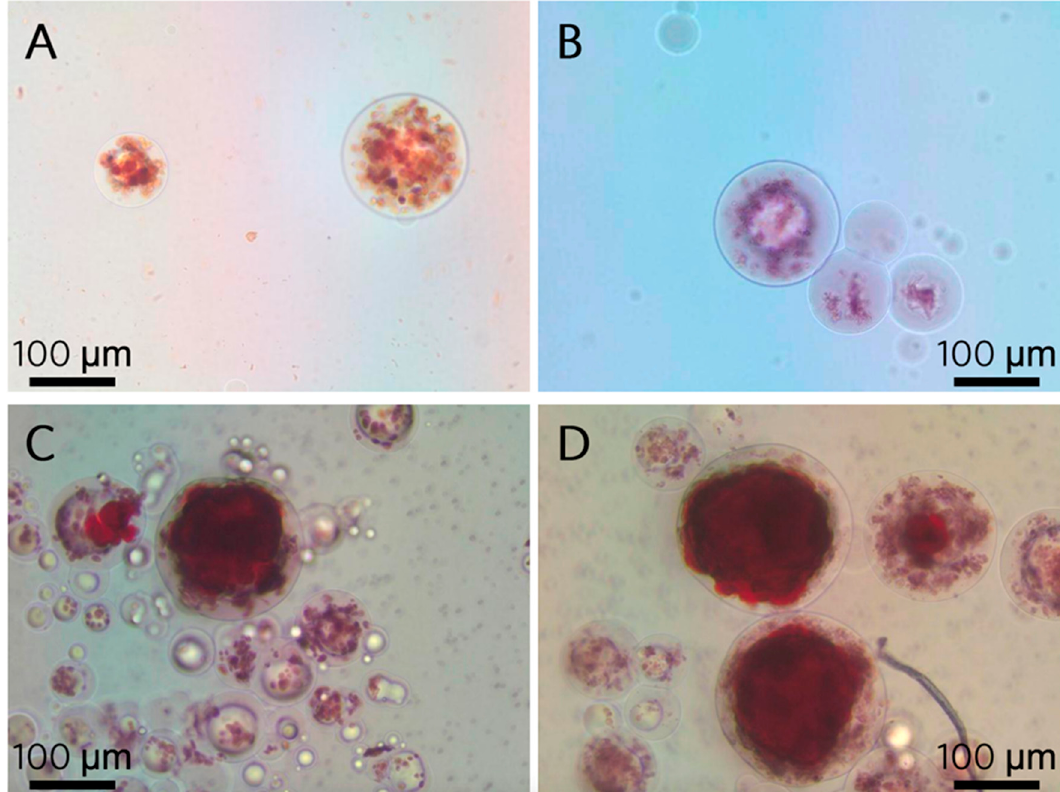
Figure 4. Representative Alizarin Red S stain of hydroxyapatite deposits at 2, 7, 32, and 50 days ( A – D ). ( A – C ) Complete maintenance basal media, ( D ) differentiation media. There were no observable differences between basal media and differentiation media, therefore ( A – C ) shows basal media.